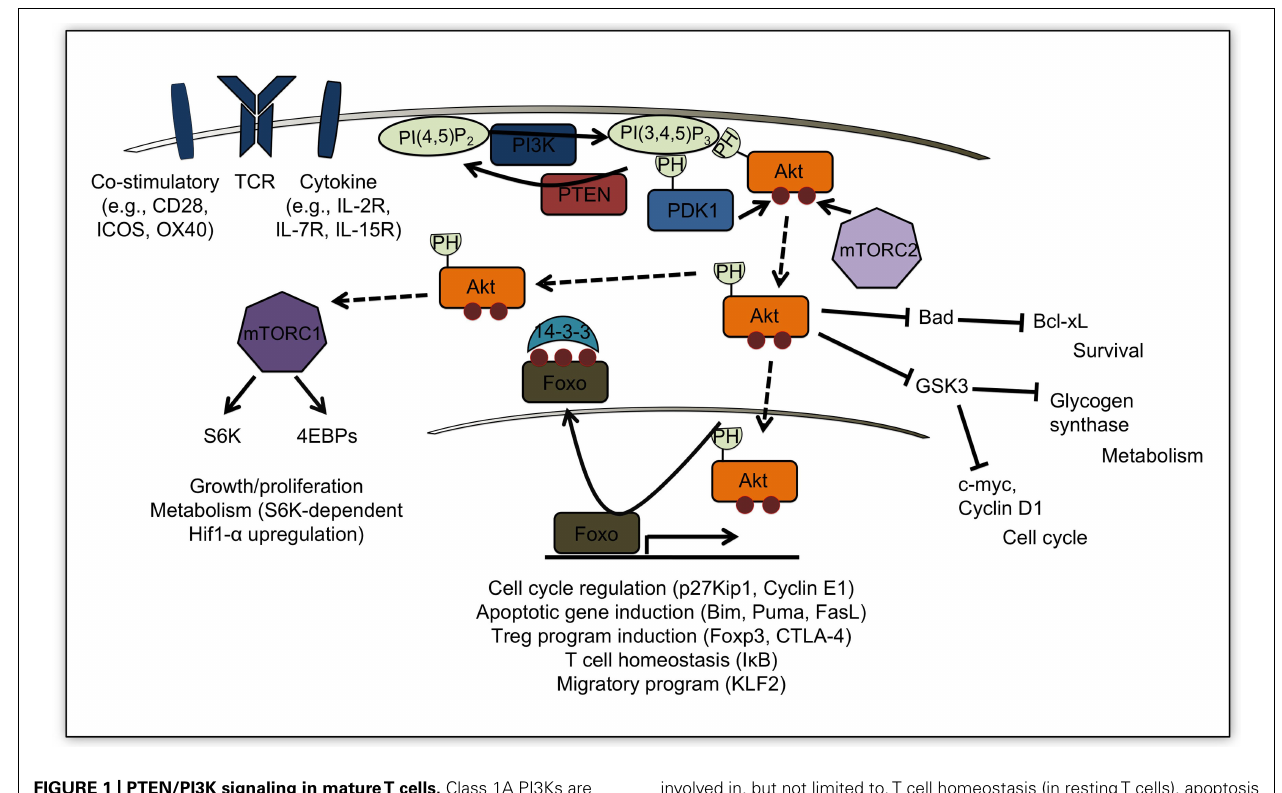
FIGURE 1 | PTEN/PI3K signaling in matureT cells. Class 1A PI3Ks are activated by receptor tyrosine kinases that drive co-stimulatory,T cell receptor (TCR), and cytokine signaling pathways. PTEN directly opposes PI3K signaling by converting PI(3,4,5)P3 to PI(4,5)P2.Through their PH-domains, PDK1 and Akt bind PIP3, enabling Akt to be phosphorylated by PDK1 on Ser308. Full activation of Akt requires phosphorylation on Ser473 by mTORC2. Akt can then target downstream substrates such as Foxos in the nucleus, leading to their inactivation and export from the nucleus.This results in attenuation of a Foxo-dependent gene program normally acting to promote pathways